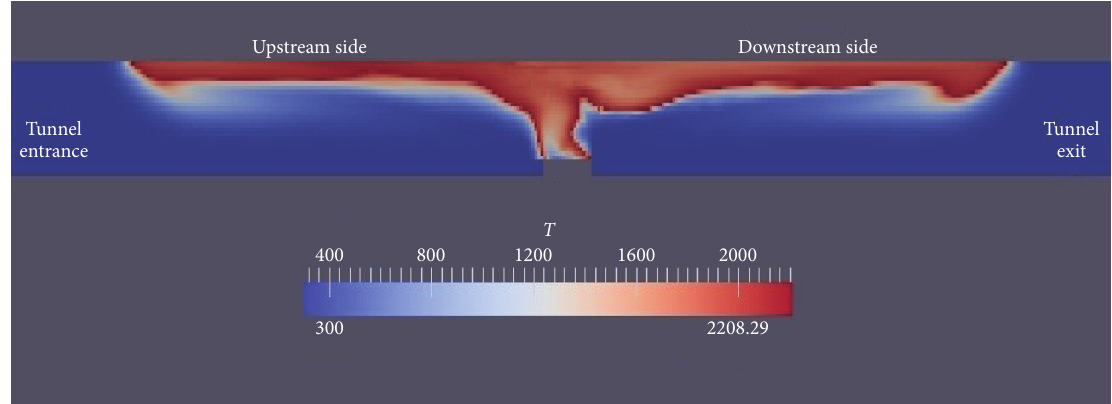
Figure 7: Streams of smoke and hot gases flowing in opposite directions along the